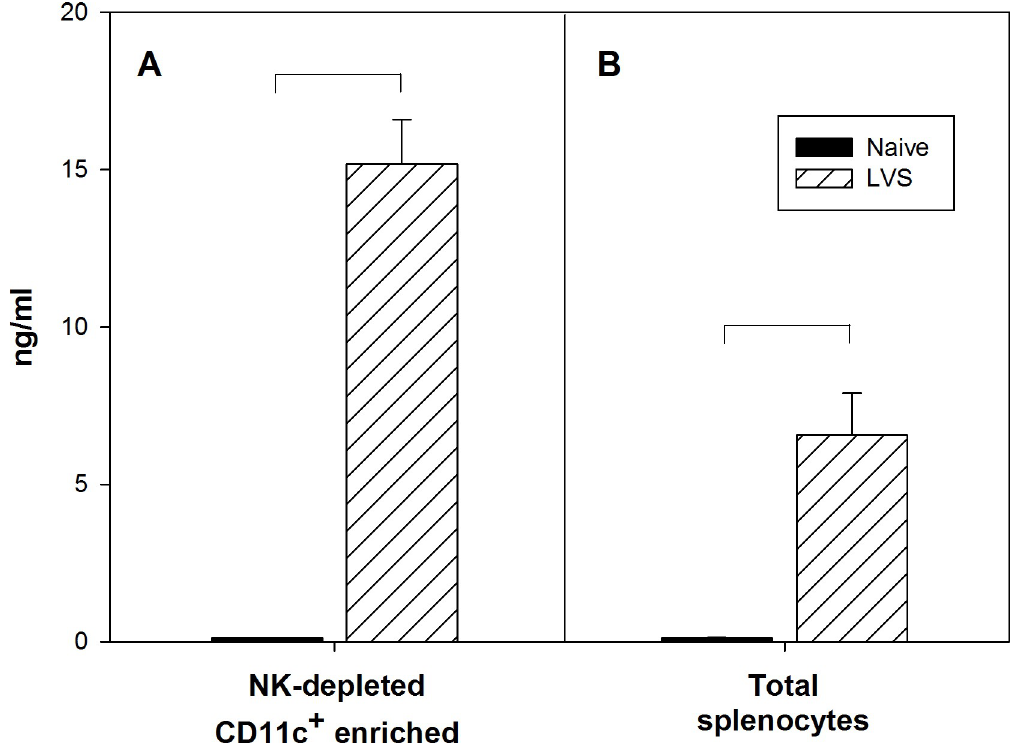
Fig 4. DC produce high amount of IFN- γ during innate immune responses to Ft LVS. Rag1 KO mice were depleted in vivo of NK cells and infected with 10 5 LVS i.d. Splenocytes were enriched in vitro for CD11c + cells using magnetic beads and cultured for three days. Supernatants were then collected and analyzed for IFN- γ production by ELISA (panel A). Production of IFN- γ from total splenocytes is shown for context (panel B). Data are from one experiment.